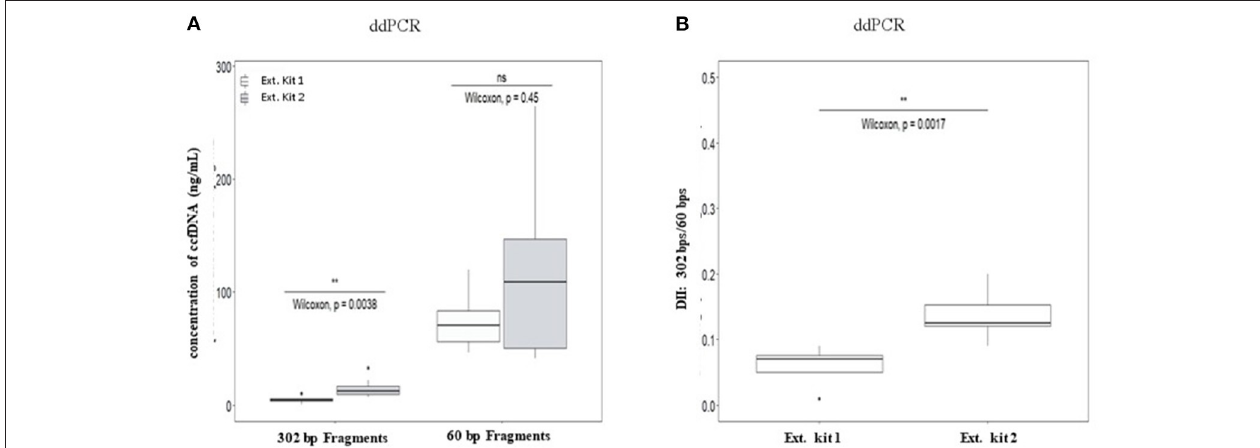
FIGURE 4 | Comparison of the influence of ccfDNA extraction methods on the resulting ccfDNA fragment concentrations (A) and DNA integrity (B) by ddPCR. Plasma from 10 healthy individuals were used in this analysis (see workflow in Supplementary Figure 1 ). Maxwell RSC ccfDNA Plasma Kit (extraction kit 1) (Promega) and QIAmp ® Circulating Nucleic Acid Kit (extraction kit 2) (Qiagen) were used for ccfDNA extraction. DII were calculated for ddPCR using 302 bp amplicon as the long fragment and 60 bp amplicon as the short fragment ( n = 8, two individuals were excluded as no ccfDNA was available) (B) . Wilcoxon test was used for significance analysis. * p < 0.05; ** p < 0.01; *** p <